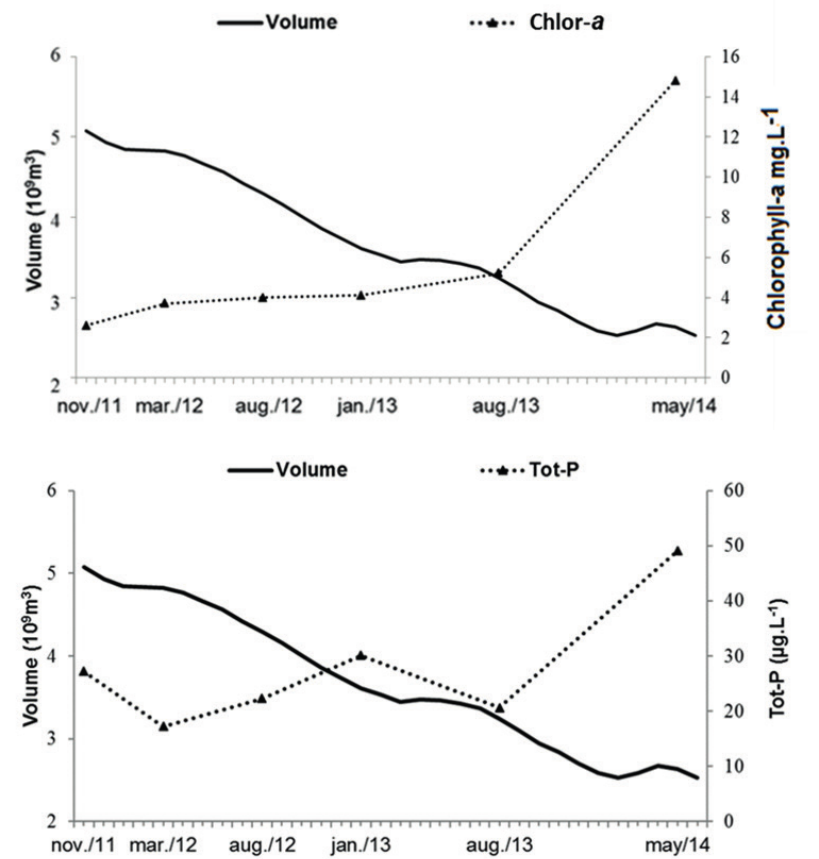
Figure 7 - Variation in total phosphorus concentrations and chlorophyll -a content relative to the total volume in the Castanhão Reservoir during the monitoring